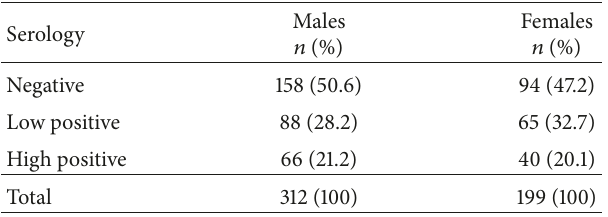
Table 2: Description of the study population by serology and gen-